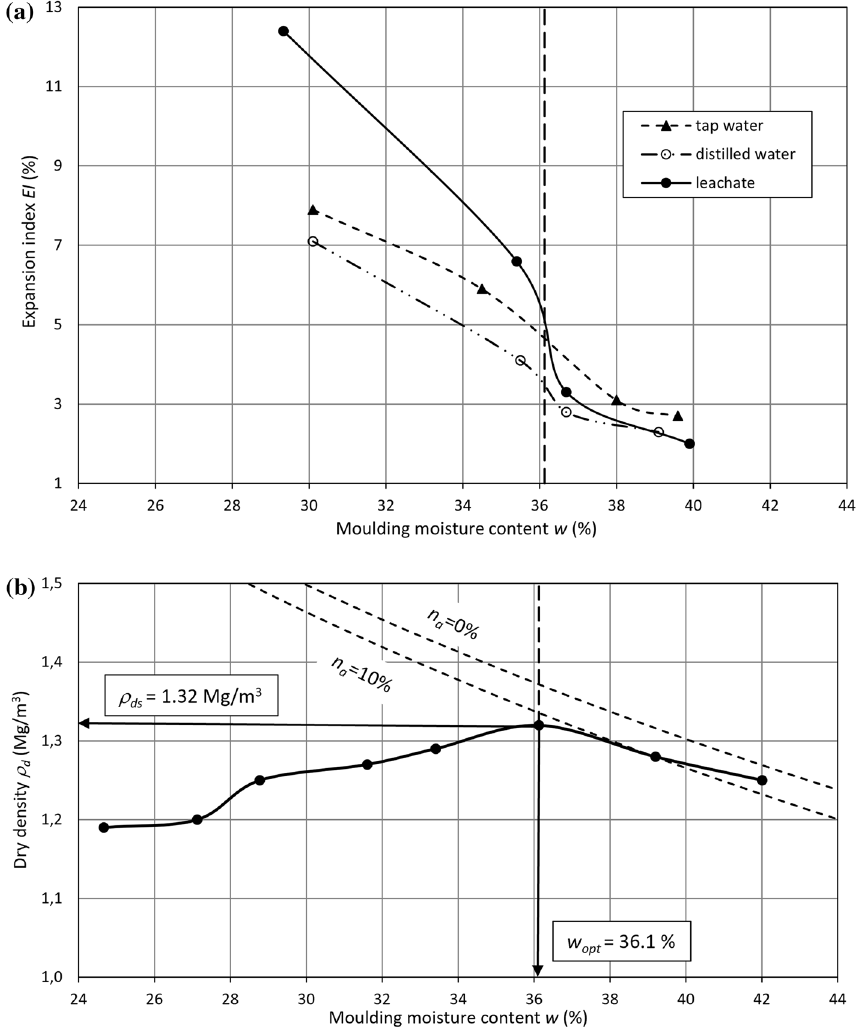
Figure 4. Expansion index versus ( a ) the moulding moisture content and ( b ) the dry